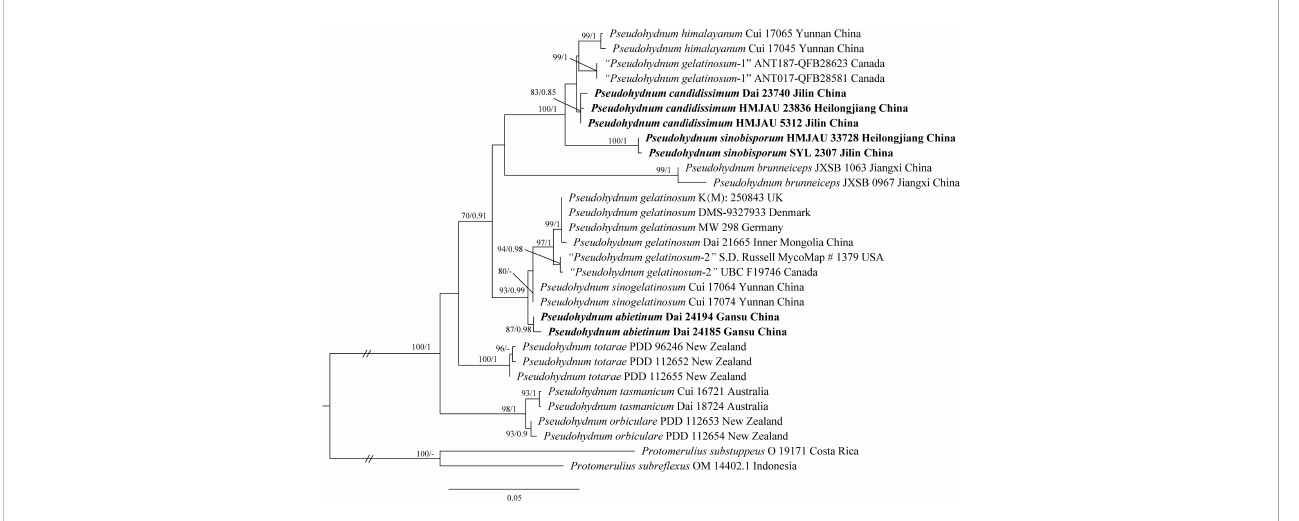
FIGURE 1 Phylogeny of Pseudohydnum species generated by maximum likelihood (ML) based on ITS + LSU sequences. Branches are labeled with ML bootstrap ≥ 70% and Bayesian posterior probabilities ≥